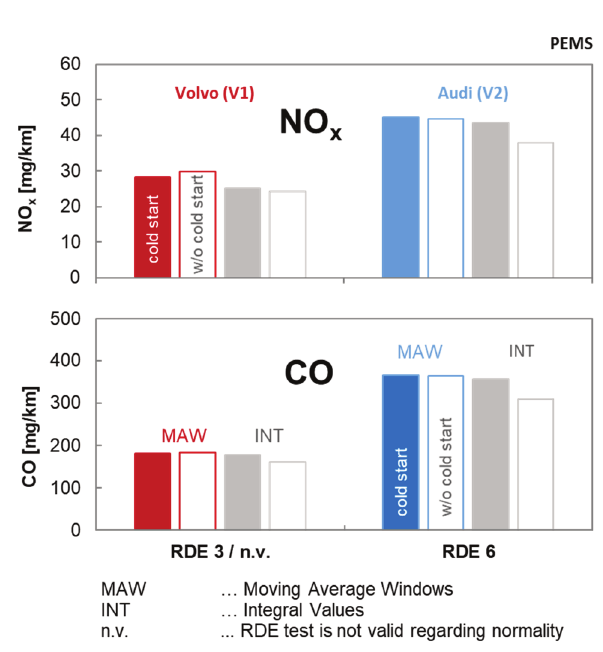
Fig. 9. Influence of cold start on emission results RDE – MAW and inte- gral values The reference dynamic conditions of the test vehicle are set out from the vehicle CO emissions versus average 2 “vehicle CO characteristic curve”. 2